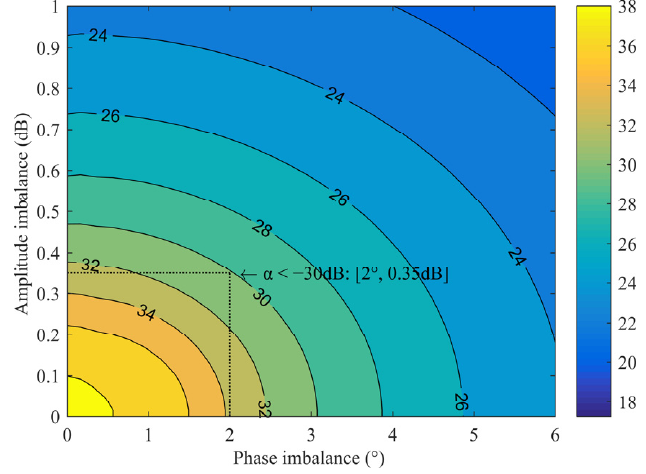
Figure 5. Amplitude and phase imbalance caused by the coupling 𝛼 .